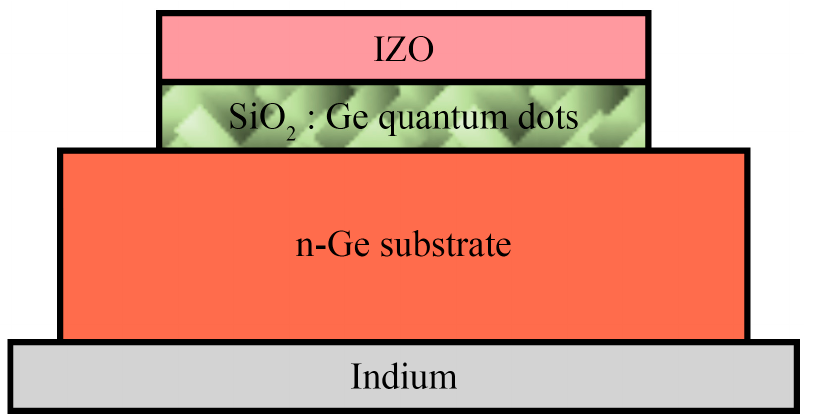
Figure 7. Schematic structure of the photodetector with Ge quantum dots in SiO 2